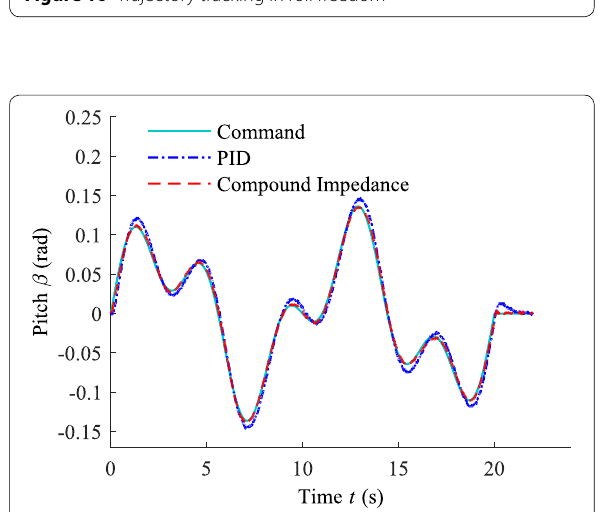
Figure 11 Trajectory tracking in pitch freedom